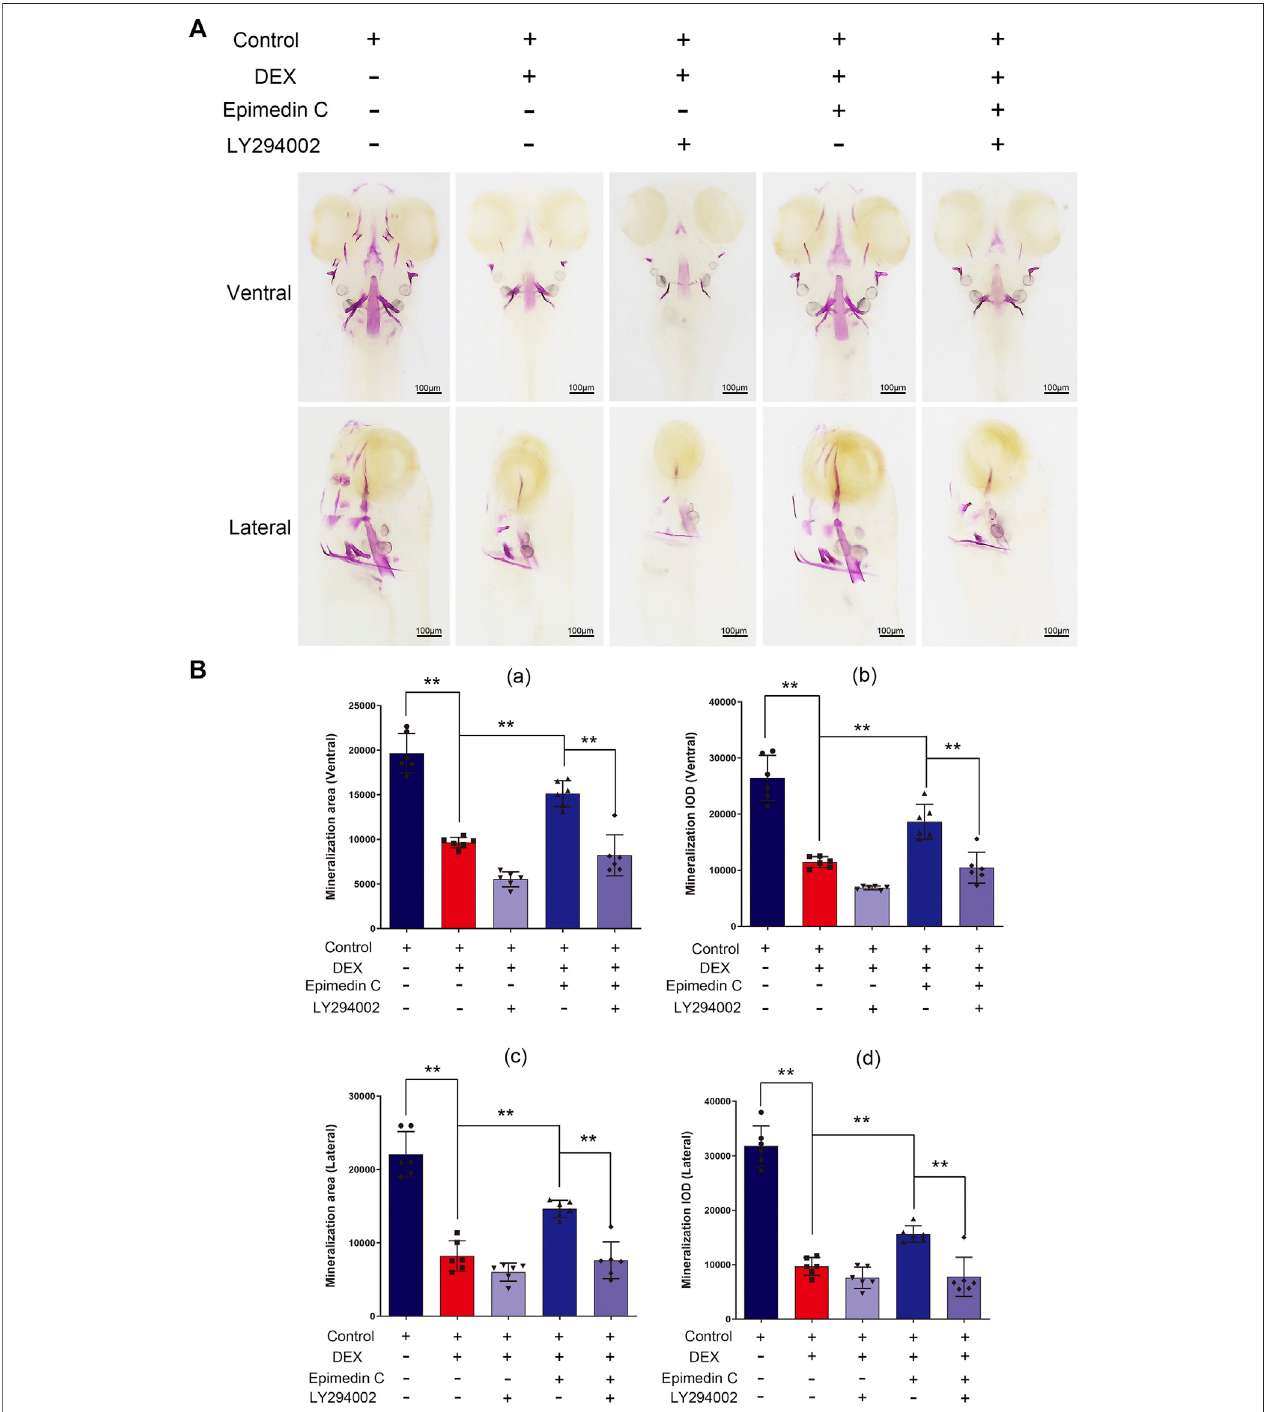
FIGURE 8 | In zebra fi sh, LY294002 suppressed epimedin C ’ s protection function in DEX-mediated decreases in skull mineralization. (A) To estimate the extent of skullmineralization, the zebra fi sh larvae withinthe DEX,DEX +Epimedin C(20 μ M), control, and DEX + Epimedin C+LY294002 groupswerestained with alizarin red S. (B) IPP was used to examine the region of skull mineralization staining with alizarin red S. **p < 0.01.